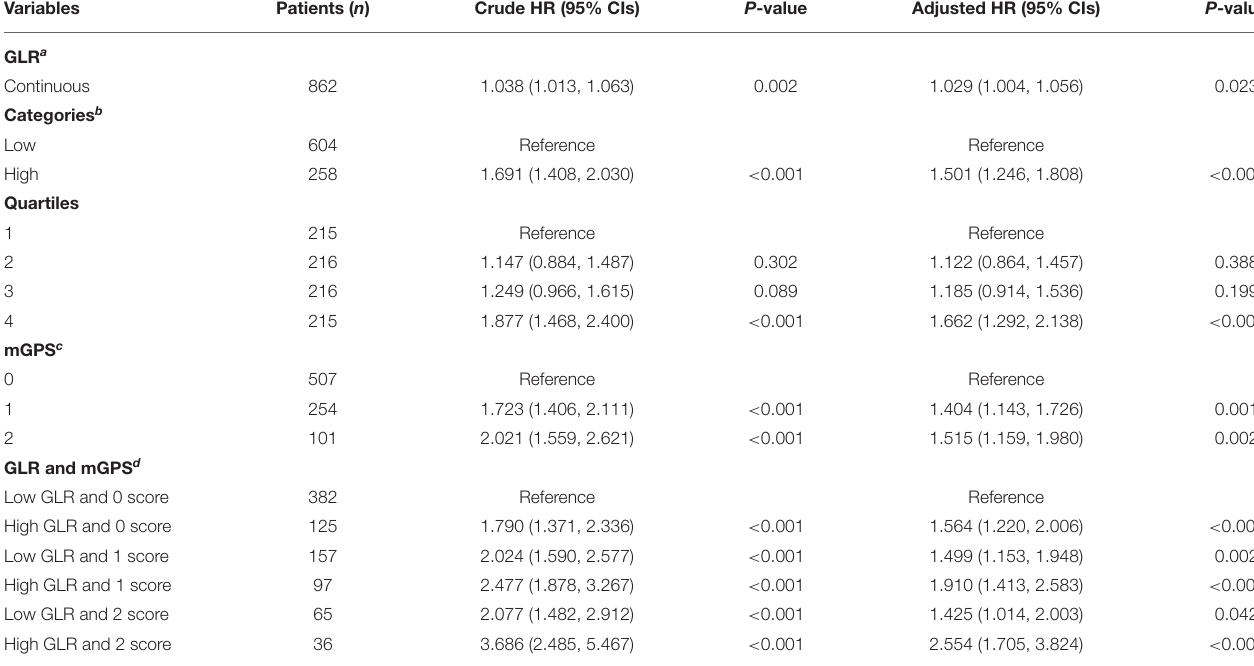
TABLE 3 | Associations between GLR or mGPS and OS in patients with NSCLC.